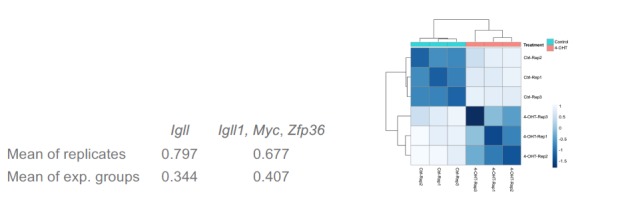
Reproducibility of MNase-seq.Correlation values between MNase-seq replicates and experimental groups at the indicated loci, 3 independent biological replicates for control cells and 3 independent biological replicates for IKAROS-induced cells (left). Base-pair level correlation for MNase sensitivity at the Igll1 promoter (right).